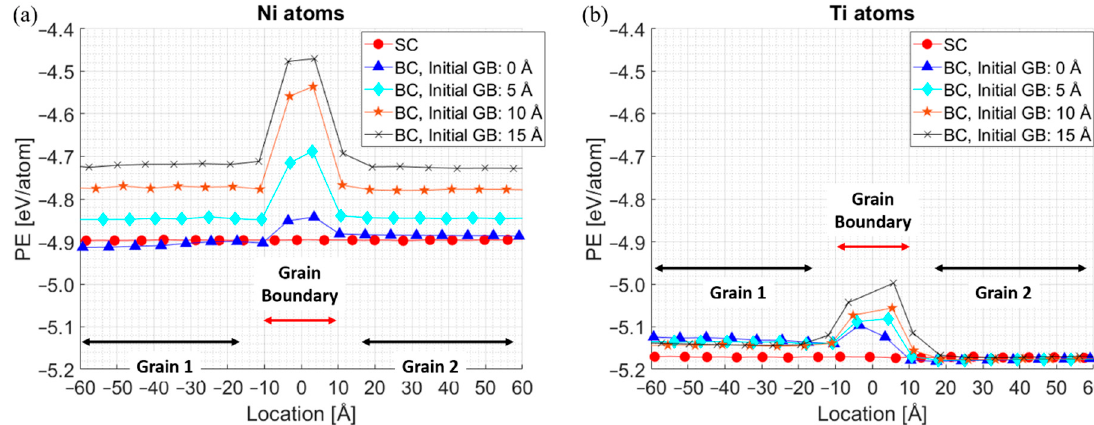
Figure 10. Potential energy distribution of Ni and Ti atoms across the grain boundary: ( a ) Ni atoms ( b ) Ti atoms.